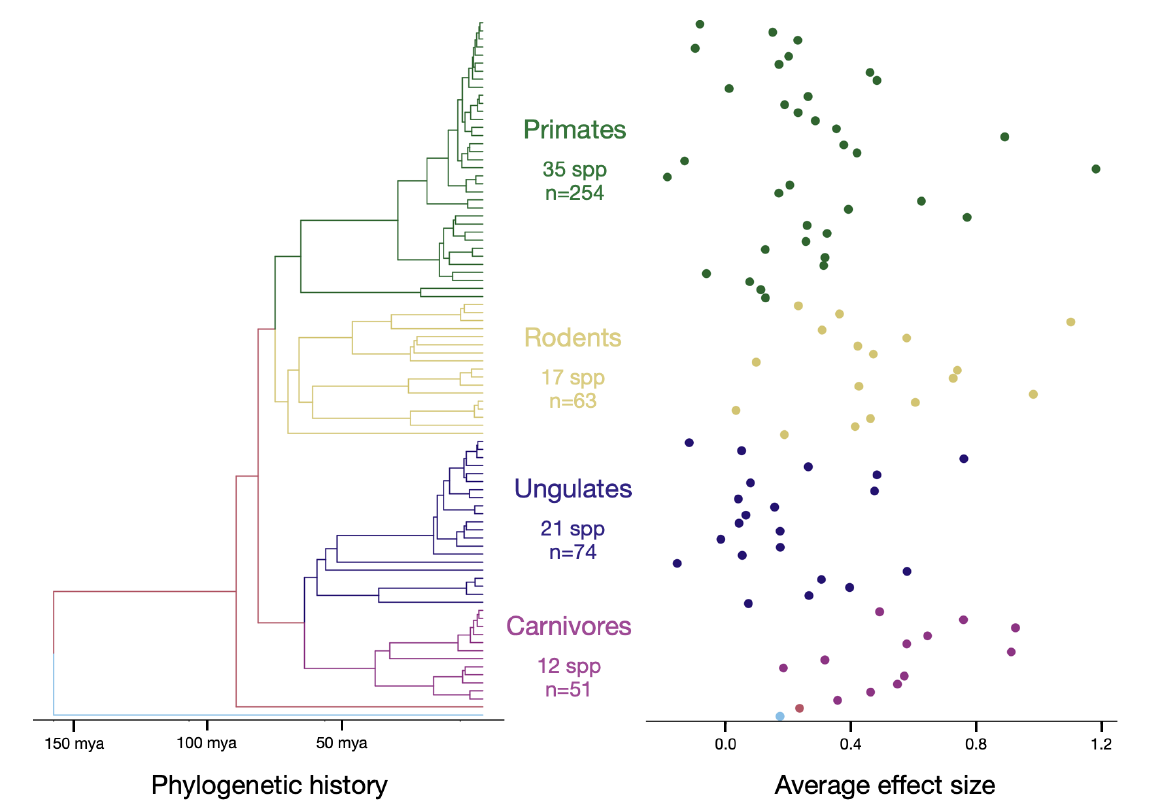
Figure 1. Phylogenetic distribution of the effect sizes in our dataset. Most effect sizes came from studies of primates (green: 254 effect sizes from 35 different species), followed by ungulates (blue: 74 effect sizes from 21 different species), rodents (yellow: 63 effect sizes from 17 species), and carnivores (purple: 51 effect sizes from 12 species), plus a single effect size each from hyraxes (red) and marsupials (aqua). Effect sizes (averaged when multiple values exist for a given species) vary even among closely related species, though there are slight differences among Orders (e.g. carnivores generally have high effect sizes, for more details see